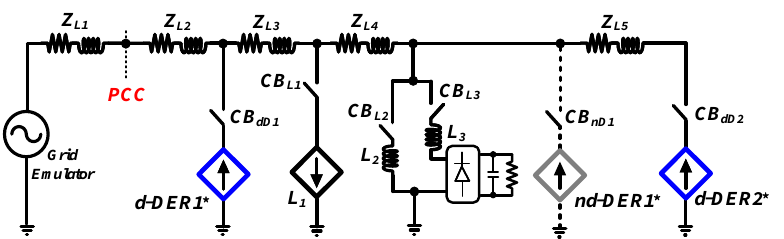
Figure 7. Equivalent circuit of the single-phase MG prototype assembled for experimental results.